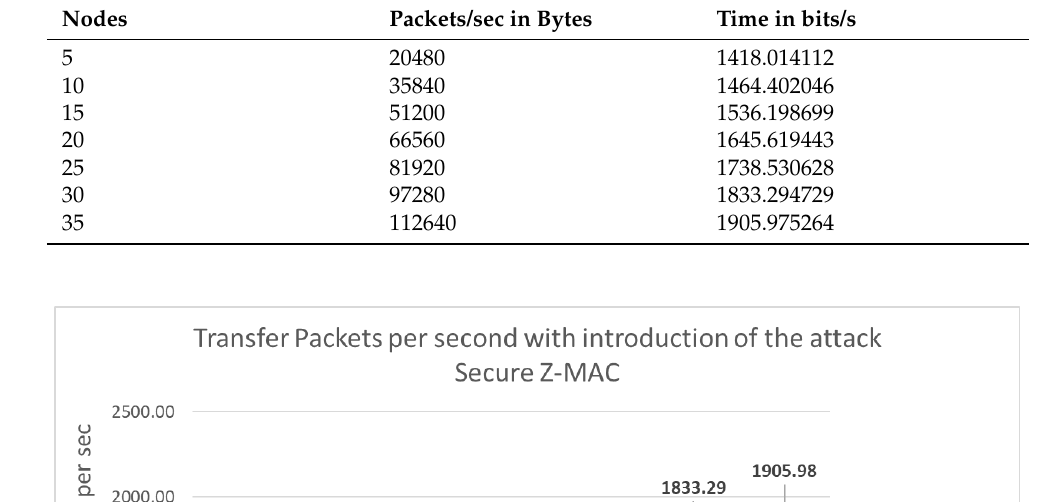
Table 6. Total transmission time for nodes using the secure Z-MAC scheme.